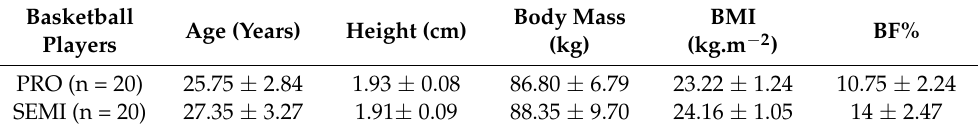
Table 1. Characteristics of the basketball players.